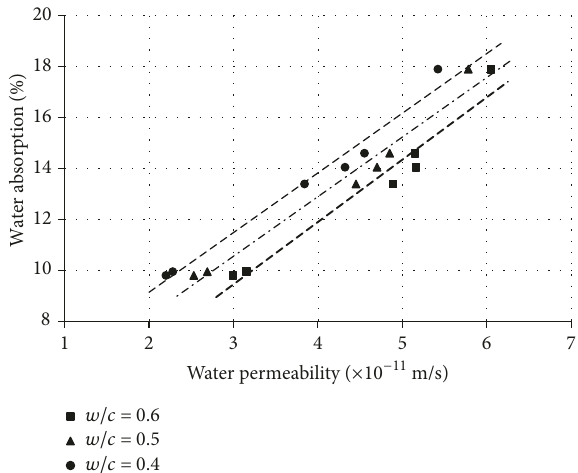
Figure 8: Water permeability with respect to water absorption of brick